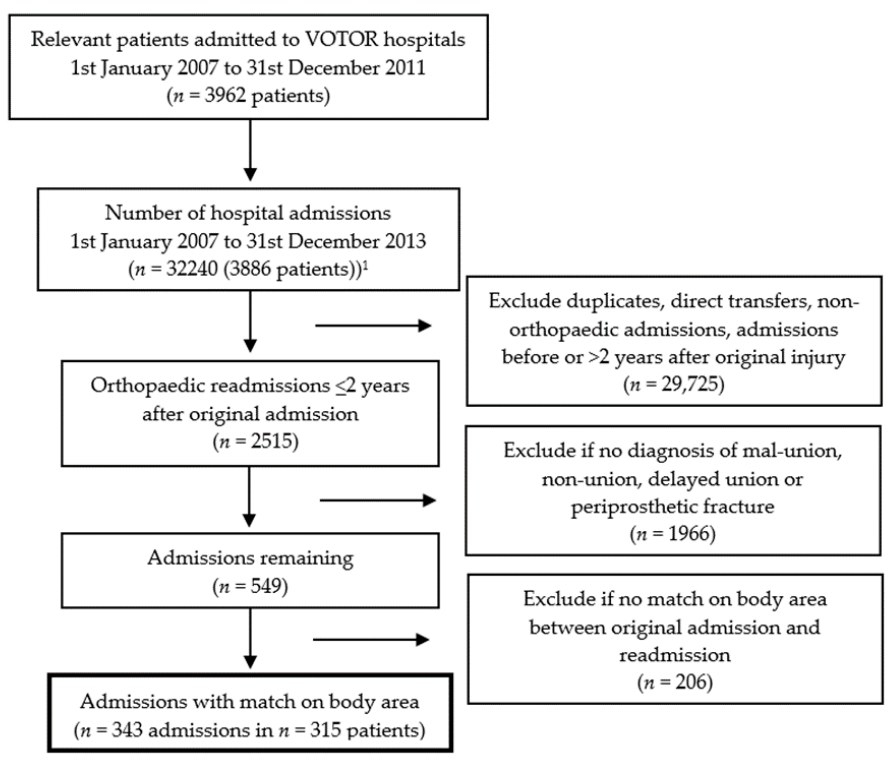
Figure 1. Case selection flow chart. 1 98% linkage.